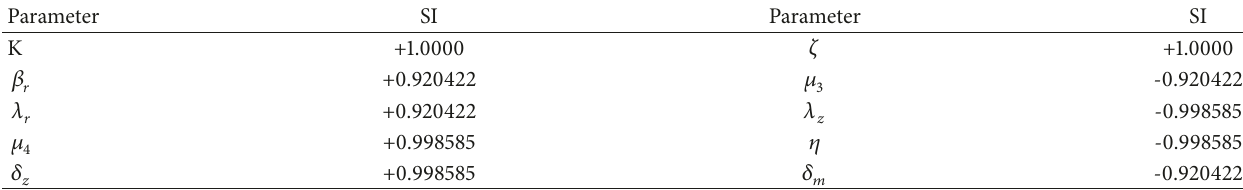
Table 4: Sensitivity indices of 𝑅 0 relative to the model